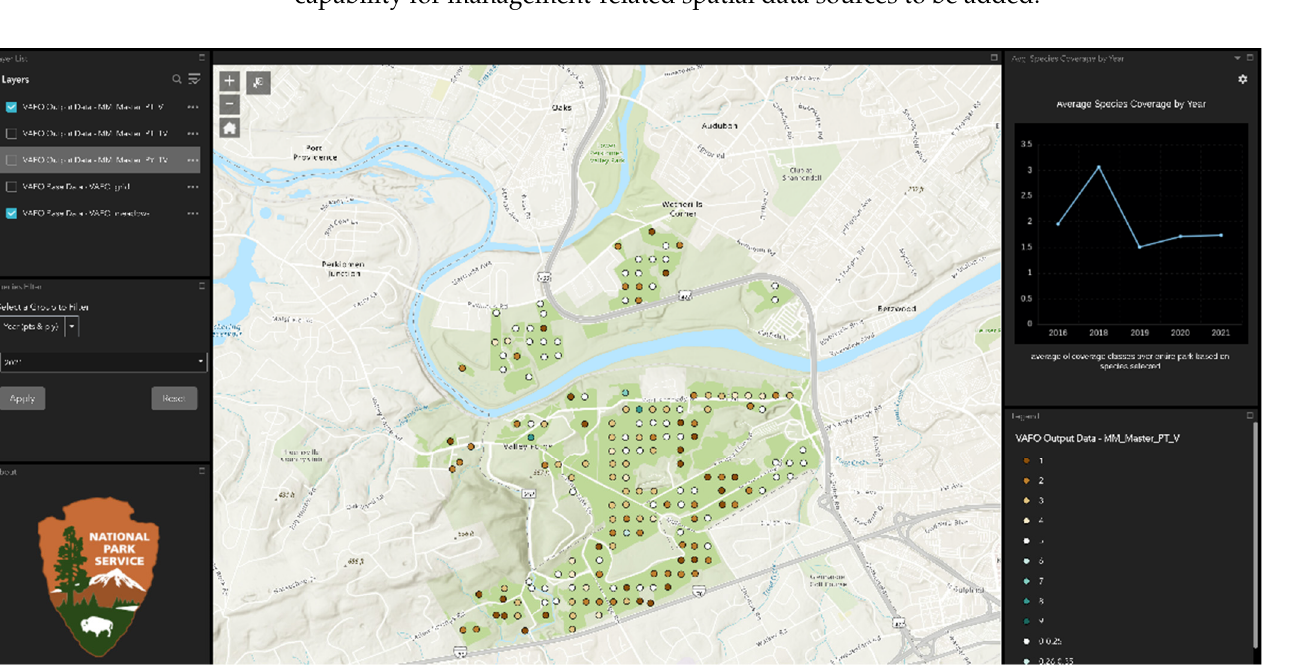
Figure 5. The Valley Forge Geospatial Meadow Management Tool (GMMT) ArcGIS Online Map Application. The map is displaying the coverage for the invasive species oriental bittersweet. Top left contains the layer list; the middle left contains the filter options. Top right contains the average coverage per year collected, and the bottom right contains the legend for all layers turned on.